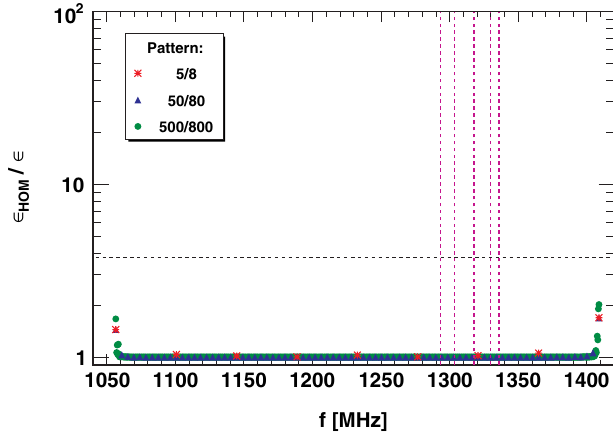
FIG. 16. Same as Fig. 15, but with strong HOM damping. N ¼ 1 , see Table